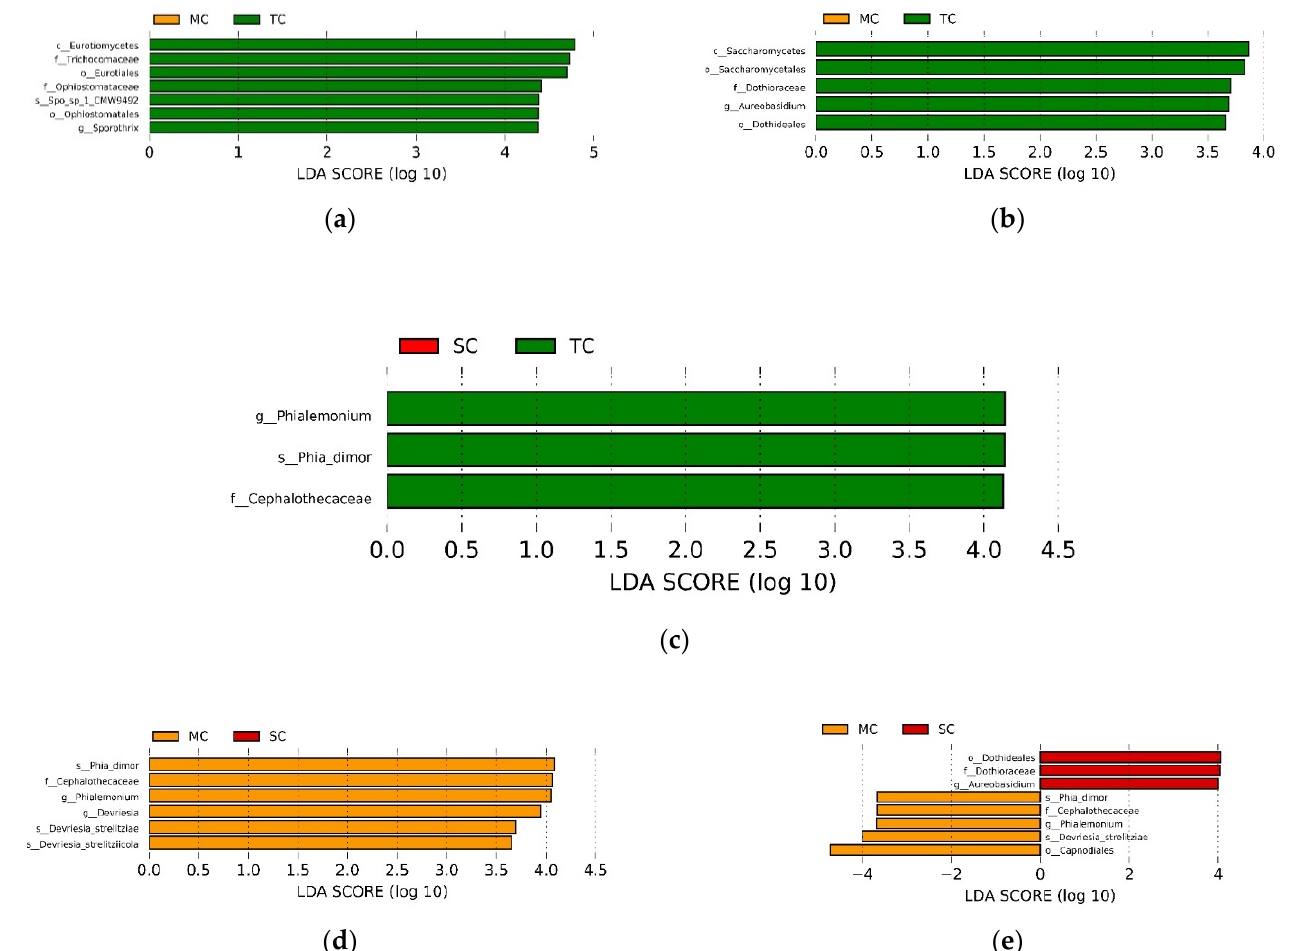
Figure 3. LEfSe analysis showing the significant differences at different fungal taxonomic levels among SC, TC, and MC communities in 0–15 cm soil layer ( a , b , d ) and 15–30 cm soil layer ( c , e ). The colors of red, green, and yellow correspond to the SC, TC, and MC communities, respectively. Abbreviation: p—phylum; c—class; o—order; f—family; g—genus; Phia_dimor—Phialemonium_dimorphosporum; and